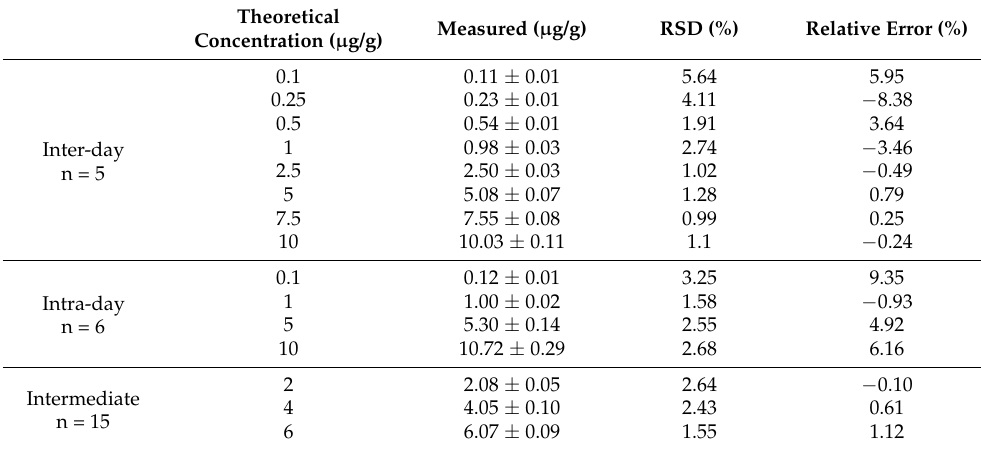
Table 2. Inter-day (n = 5), intra-day (n = 6) and intermediate (n = 15) precision and accuracy. All concentrations are in µ g/g. RSD, relative standard deviation. When applicable, values are presented as mean values ± standard